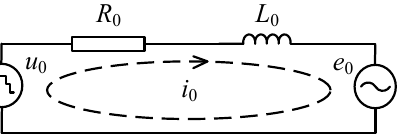
Figure 3. Zero-sequence loop in series-winding topology.